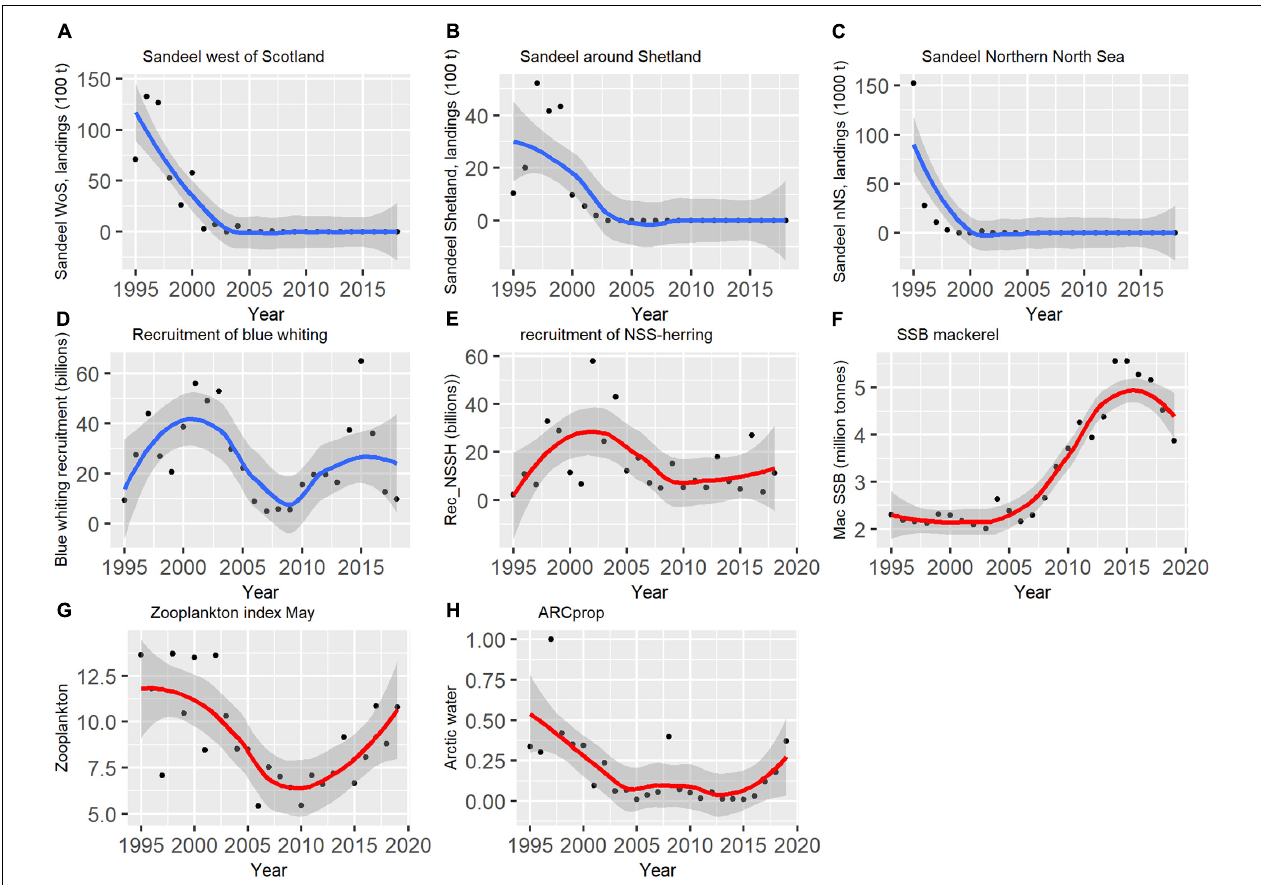
FIGURE 5 | Temporal development of prey abundance and environmental indices potentially important for post-smolts in the Northeast-Atlantic. Indices represented with a blue line is south of the Norwegian Sea, while red lines represent indices for the Norwegian Sea. (A) Sandeel landings west of Scotland (woS), (B) sandeel landings around Shetland, (C) sandeel landings in the northern North Sea, (D) recruitment of blue whiting, (E) recruitment of Norwegian spring-spawning herring (NSSH), (F) spawning stock biomass mackerel (G) zooplankton index May, (H) index for the proportion of arctic water (ARC prop ), and (I) salinity of Atlantic water (ATL smax ). The figure was produced with the use of the following R-packages: ggplot2 (Wickham, 2016) and cowplot (Wilke,